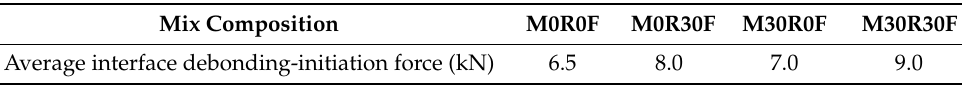
Table 4. Average interface debonding-initiation force.